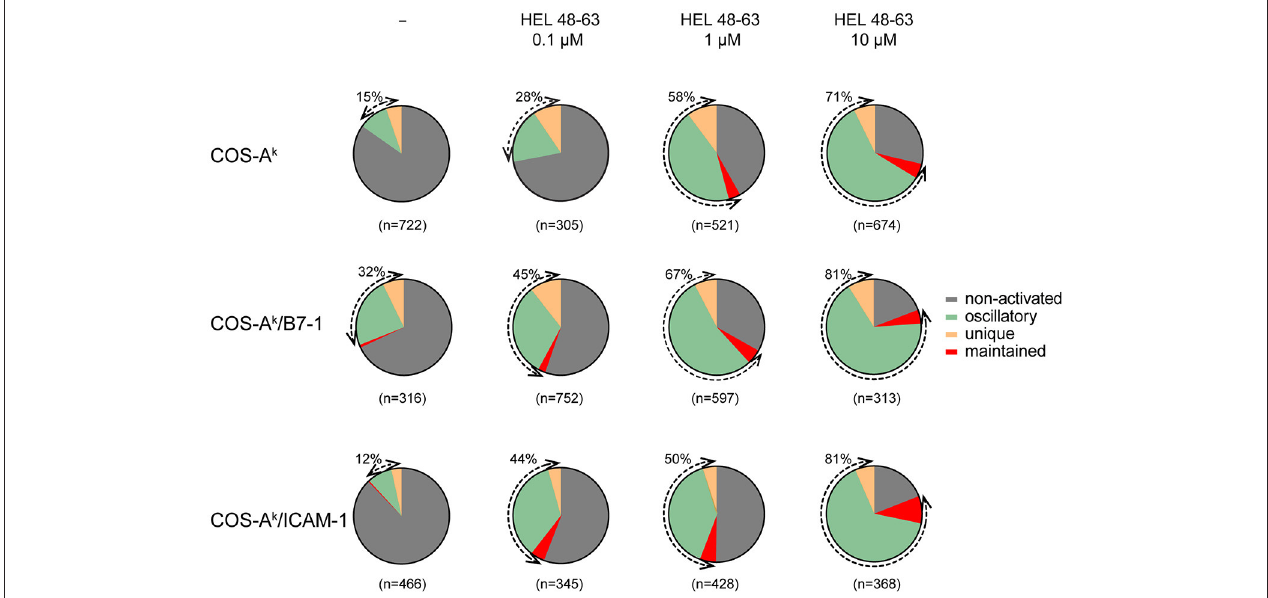
FIGURE 3 | Naive CD4 + T cells show various calcium response modes upon different stimulation. Naive 3A9 TCRtg CD4 + T cells were loaded with Fluo-4 PBX before incubation at 37 ◦ C for 45min with COS APC cells pulsed without or with different doses of HEL 48–63 as indicated. Time-lapse movies of T cells were made by confocal microscope as described in Materials and Methods. For each antigenic peptide concentration, modes of calcium response are represented as a pie chart: non-activated in gray, maintained in red, oscillatory in green, and unique in yellow. The total number of cells analyzed is indicated in parentheses. The percentage of activated (reacting) cells is shown by the double arrows, and their values are